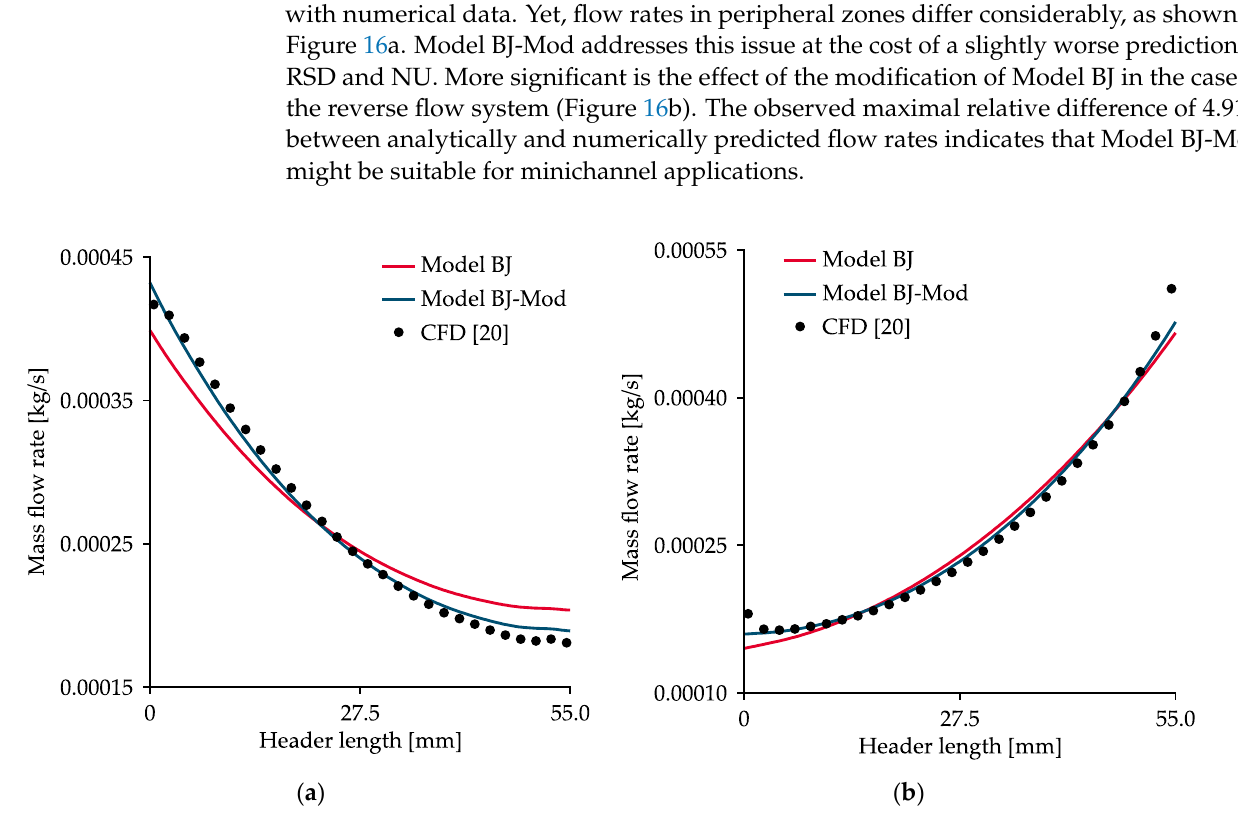
Figure 16. Comparison of the flow rates obtained using the analytical models with the CFD data taken from the literature: ( a ) minichannel system with the U-arrangement; ( b ) minichannel system with the Z-arrangement.